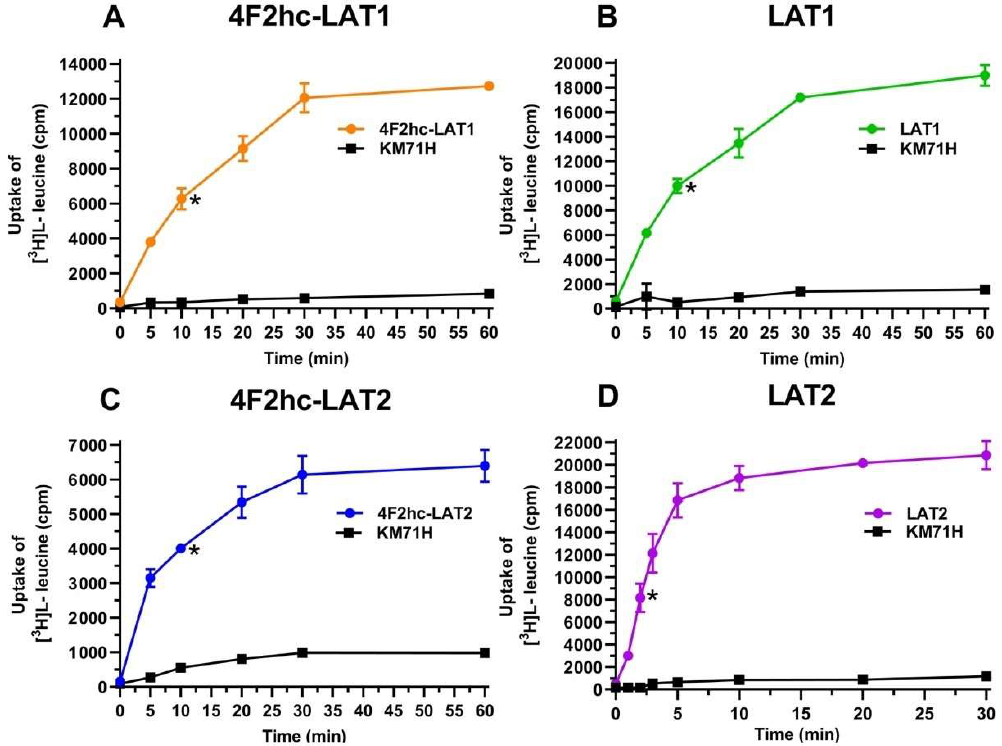
Figure 1. Time-dependent uptake of 100 nM [ 3 H]L-leucine into P. pastoris KM71H cells expressing 4F2hc-LAT1 (( A ); orange), LAT1 (( B ); green), 4F2hc-LAT2 (( C ); blue), or LAT2 (( D ); violet). [ 3